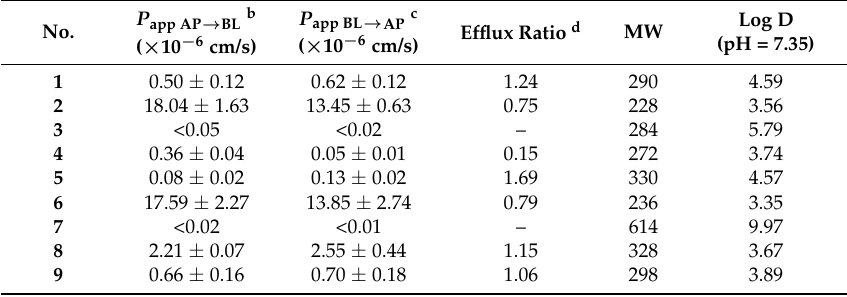
Table 2. The bidirectional P app values of compounds 1 – 9 in Caco-2 cell monolayer ( n = 4) a . No.